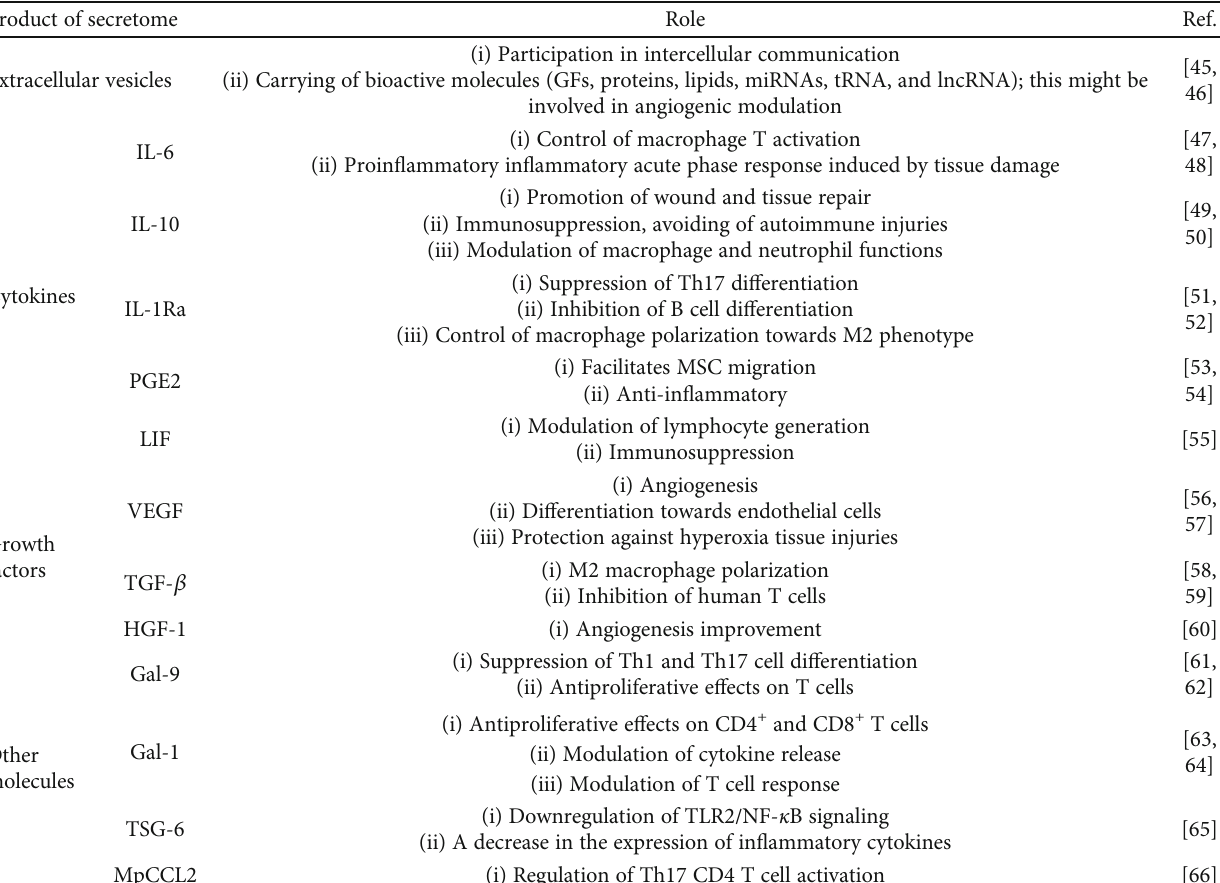
Table 2: Some of the molecules secreted by MSCs and their